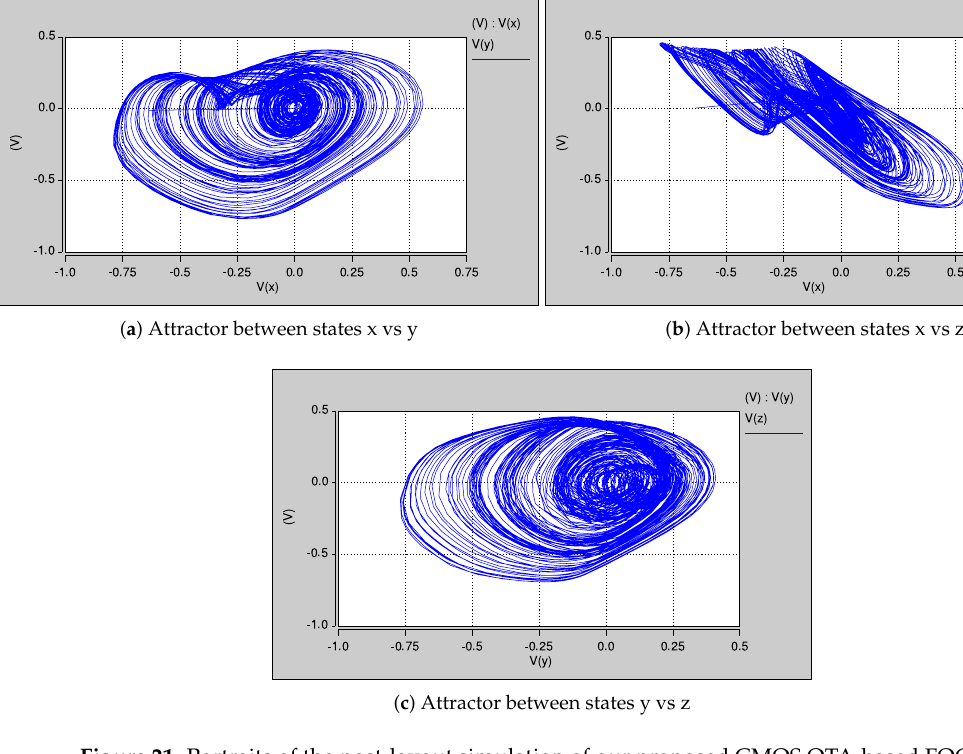
Figure 21. Portraits of the post-layout simulation of our proposed CMOS OTA-based FOCO 1